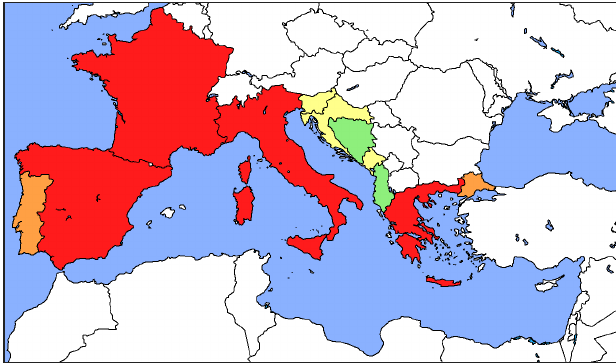
Fig 1 . Map of the Mediterranean region. The areas not considered in this study are left blank. Areas hosting no exotic ant species are marked in green, areas hosting a single exotic ant species are marked in yellow, areas hosting 4-7 exotic ant species are marked in orange, the remaining countries, hosting 14-21 exotic ant species, are marked in